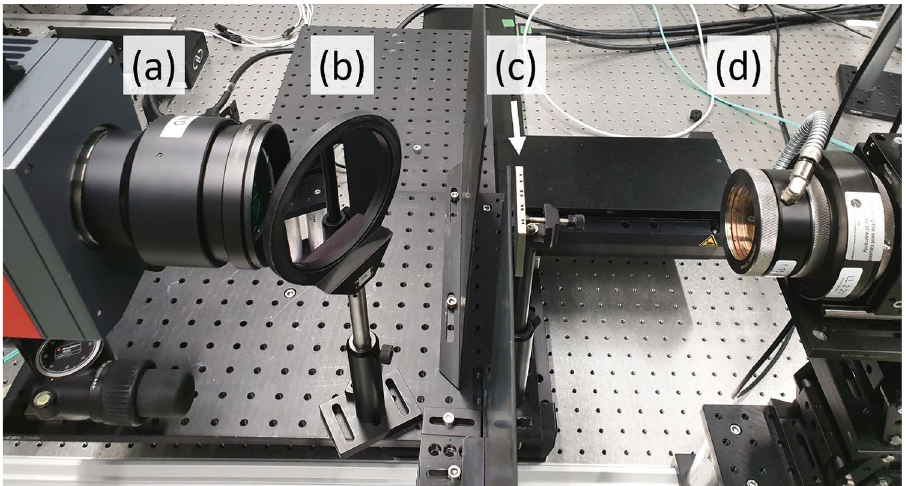
Figure 2. Exemplary transmission configuration for laser excited super resolution thermography from our laser laboratory at BAM: ( a ) IR camera, ( b ) dichroic mirror (used to protect the IR camera from laser beam fractions), ( c ) investigated stainless steel specimen shown in Fig. 1, ( d ) high-power fiber-coupled laser. ( a – c ) are mounted on a linear stage using an optical breadboard. The position of the linear stage is shifted by a motion controller in submillimeter range which is necessary for optical super